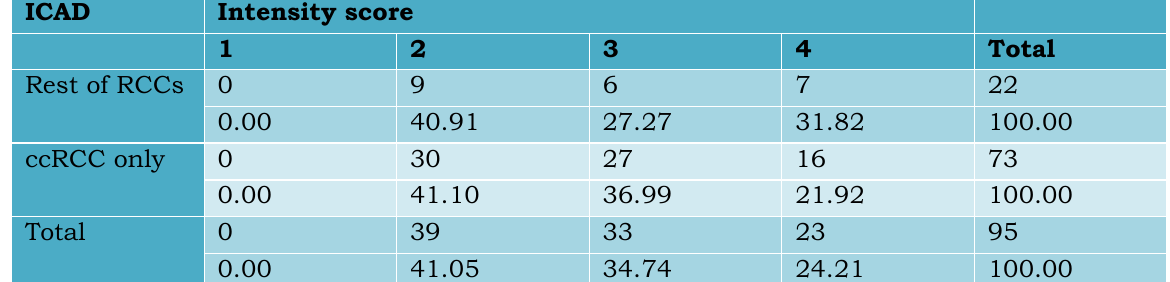
Table 2. Comparison of RCC subtypes with ICAD protein intensity (Pearson  2 )